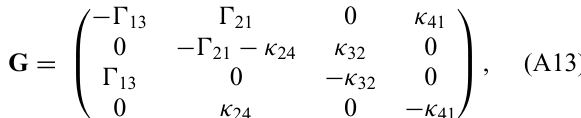
FIG. 11. Antibunching amplitudes. (a)–(e) Antibunching amplitudes (circles) of QEs A to E. The error bars represent one standard deviation. The dashed lines are fits using an empirical model discussed in the text. (f) Simulated antibunching ampli- tudes as a function of the excitation rate for the spontaneous (circles) and pumped (squares) transition mechanisms discussed in the main text.